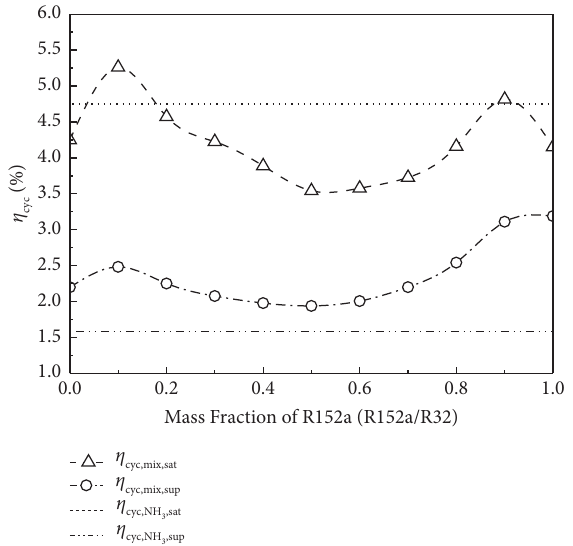
Figure 6: Termal efciency of OTEC-ORC with R152a/R32 and NH 3 as working fuids in a superheated and saturated state.